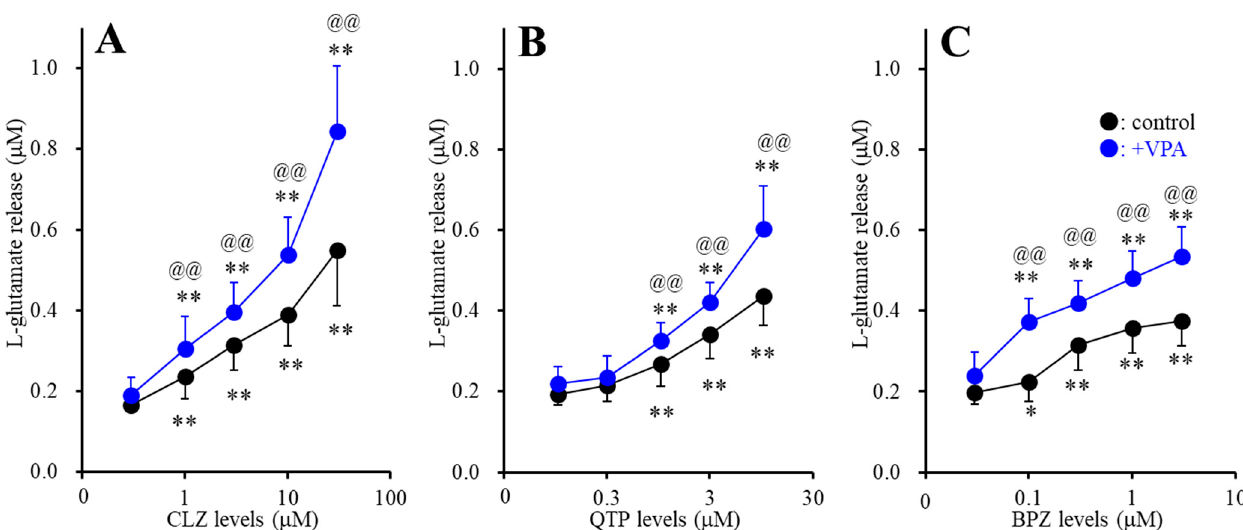
Figure 3. Interaction between subchronic (for 7 days) administration of therapeutic-relevant concentration of VPA (500 µ M) and antipsychotics, CLZ ( A ), QTP ( B ) and BPZ ( C ) on L -glutamate release through activated hemichannel. Ordinate: mean ± SD ( n = 6) of the FCHK-evoked astroglial L -glutamate release ( μ M), and abscissa: concentration of CLZ, QTP and BPZ ( μ M). Black and blue circles indicate acute antipsychotics administration alone (control) and combination of subchronic administration of VPA with antipsychotics (+VPA), respectively. * p < 0.05, ** p < 0.01: relative to antipsychotics free, @@ p < 0.01: relative to control by MANOVA with Tukey’s post hoc test.